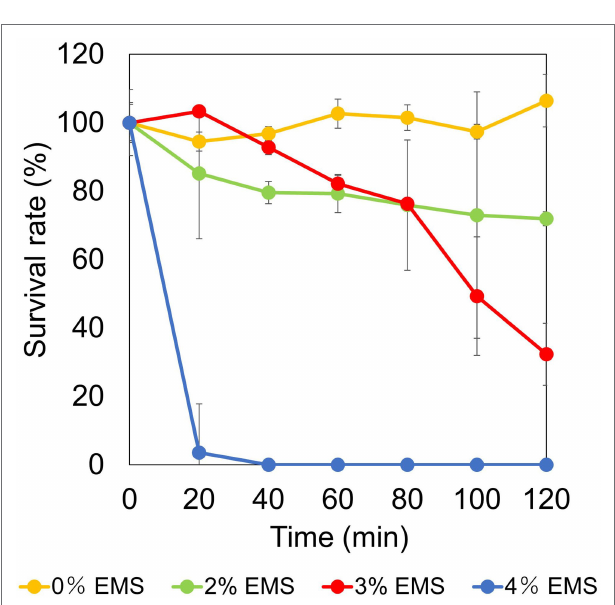
FIGURE 3 | Examination of conditions for chemical mutation treatment by ethyl methanesulfonate (EMS) in strain TS-1. The figure shows the change in survival rate depending on the EMS concentration when the strain TS-1 was subjected to chemical mutation treatment for 120 min. The vertical axis shows the survival rate obtained from the viable cell count, the horizontal axis shows the EMS concentration used for the chemical mutation treatment, and the error bar shows the SD for three independent